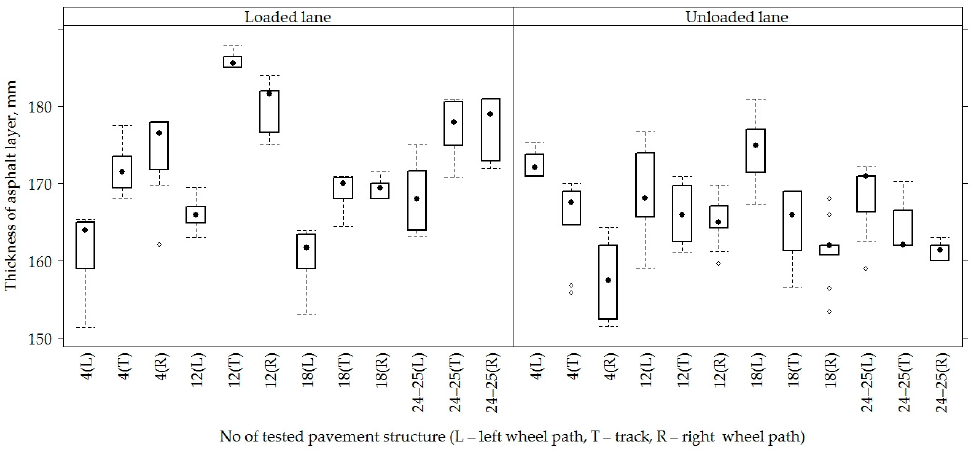
Figure 5. The box-plot of the total thickness of the asphalt concrete (AC) layers in different PSs on different lanes.